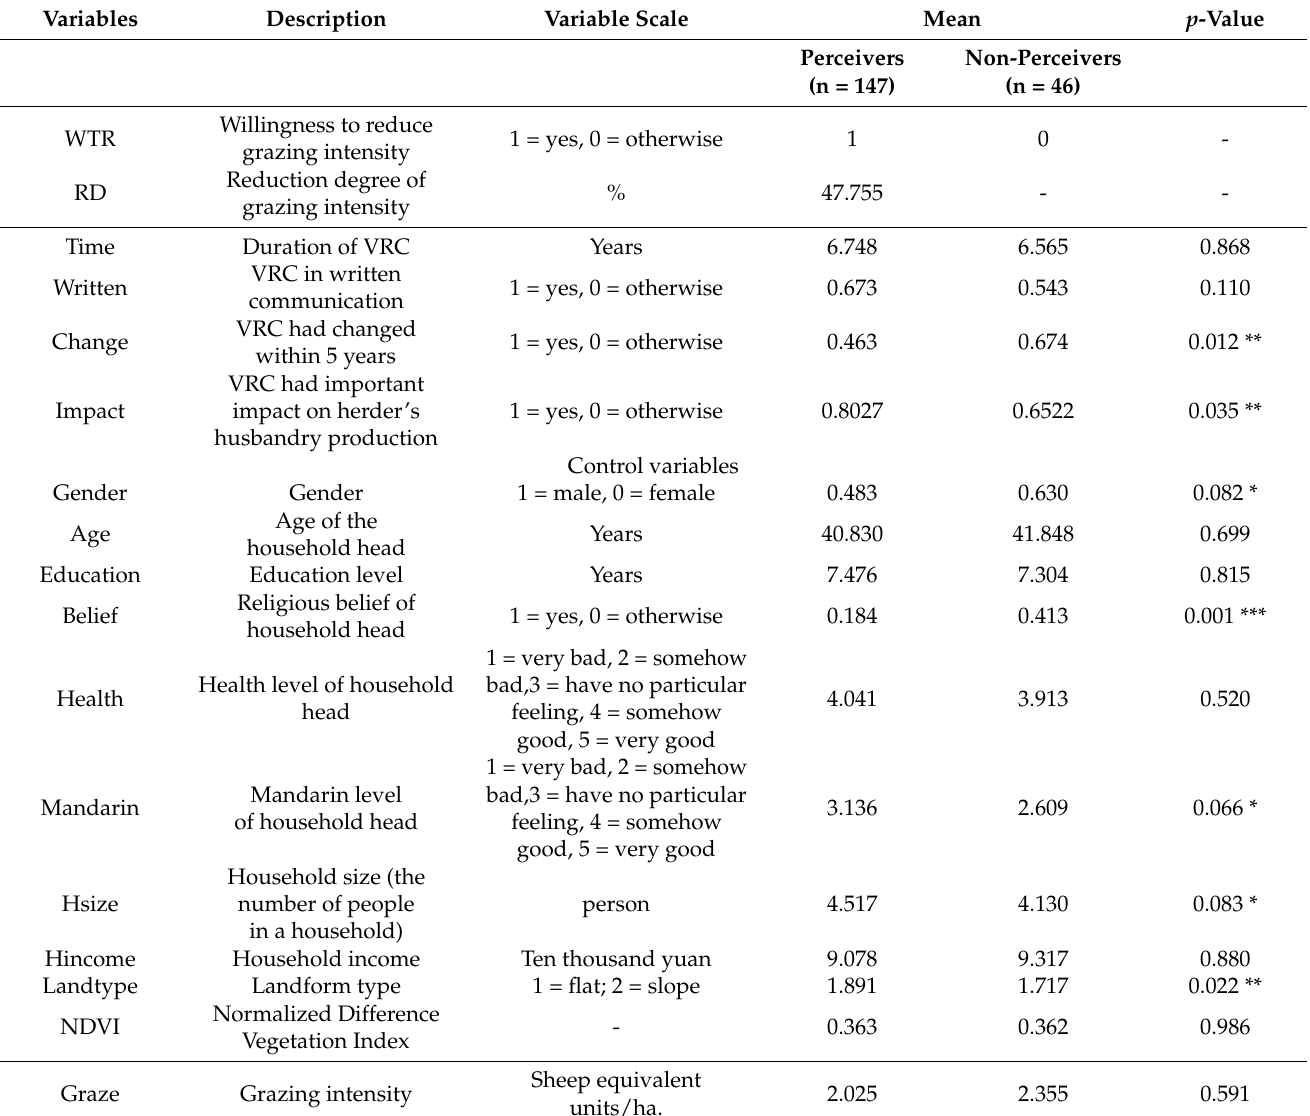
Table 3. Variable definitions and summary statistics.